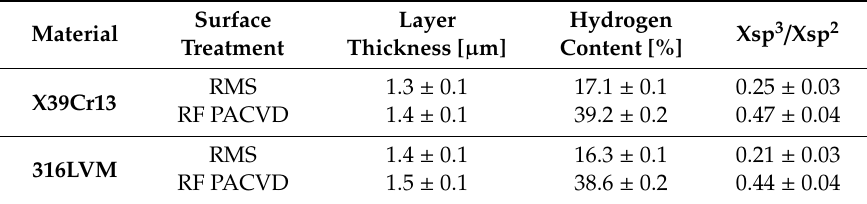
Table 2. Results of diamond-like carbon (DLC) layer